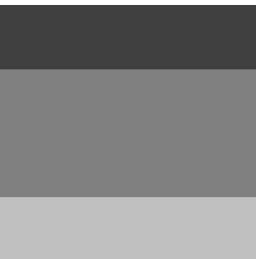
Figure 1. The image pattern used to analyze the noise characteristics in the image reconstructed from holograms calculated by iterative Fourier transform algorithms (IFTAs).